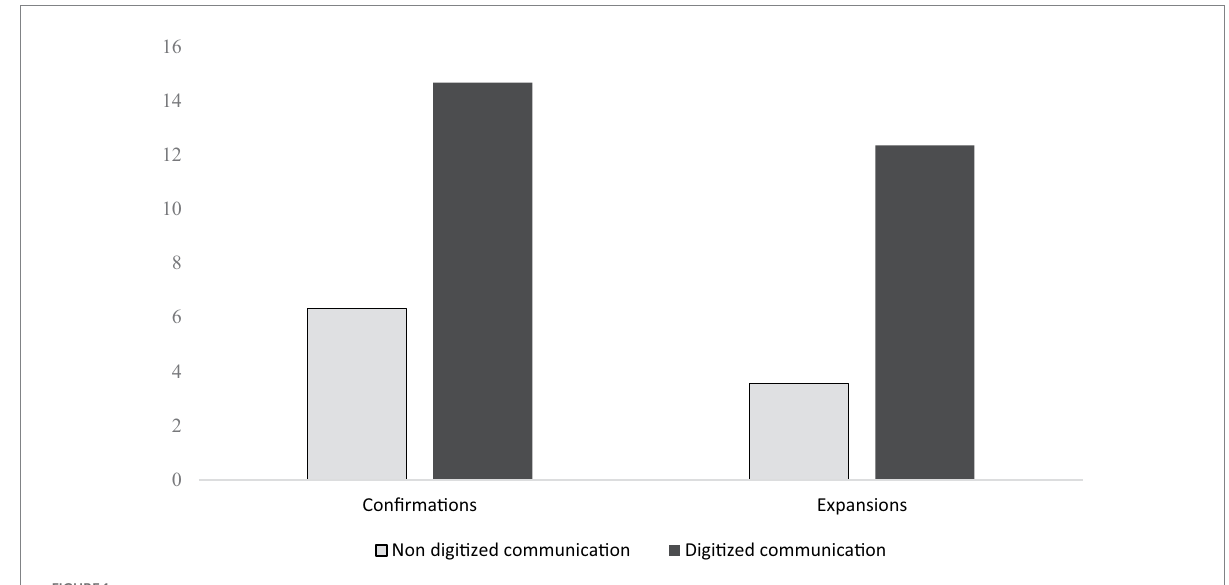
FIGURE 1 The rate of the communication partner’s confirmations to, and expansions on, the participants’ non digitized, and digitized communication. Both differences were significant, p < 0.005. For confirmations, Z = − 3.597, for expansions, Z = −